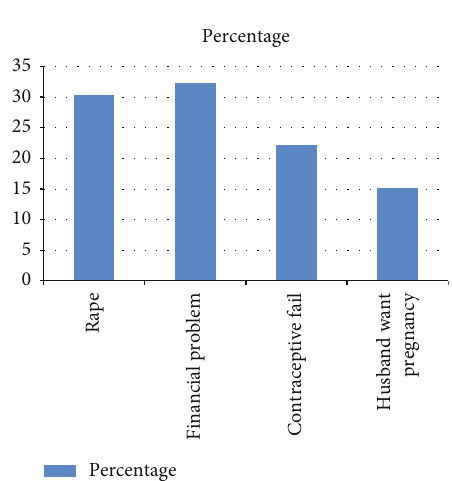
Figure 1: The reason of unintended pregnancy among pregnant women living in Ilu Gelan district, West Shewa Zone, Ethiopia, 2021 ( n = 540 ).